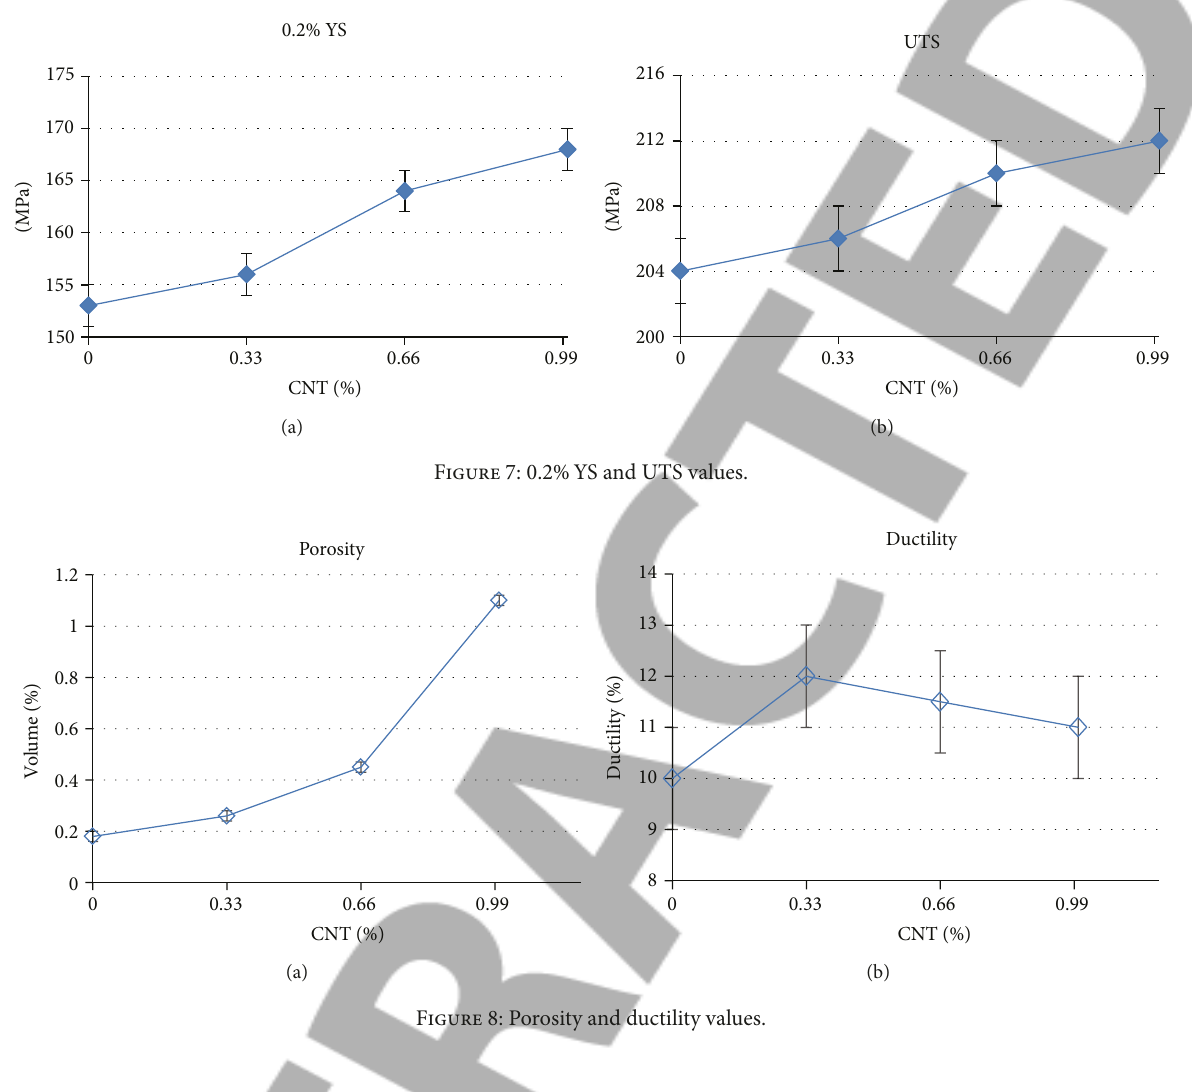
Figure 7: 0.2% YS and UTS values.